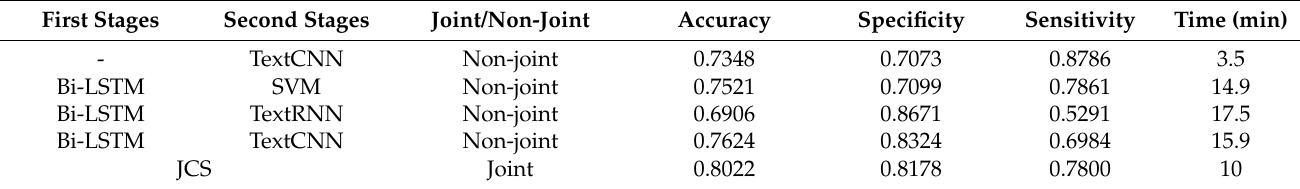
Table 3. Comparison between our model and prevalent methods.